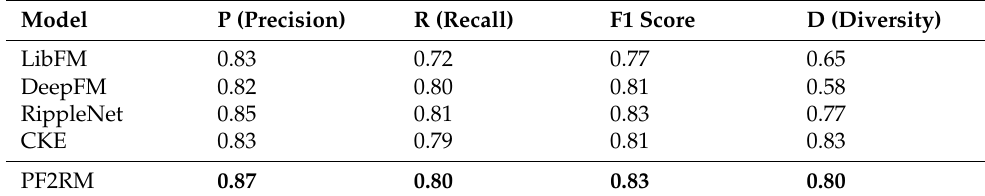
Table 3. User click recommendation model evaluation table.